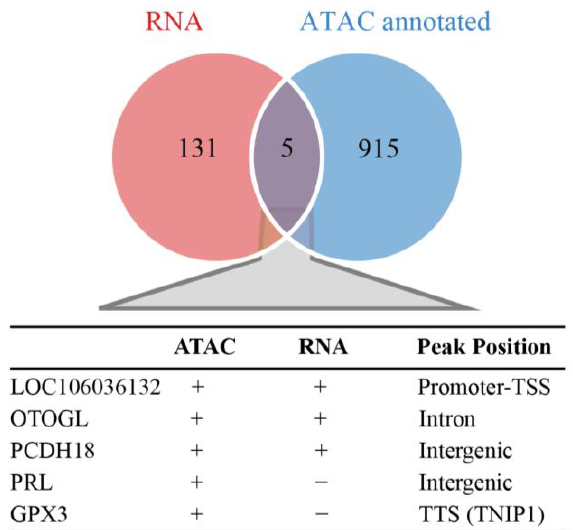
Figure 5. Joint analysis of ATAC-seq and RNA-seq. The above Venn plot shows the overlap analysis of differentially open regions and differentially expressed genes. The table below shows the differential changes in five overlapping genes in the two omics, details about openness and gene expression can be observed in the table.